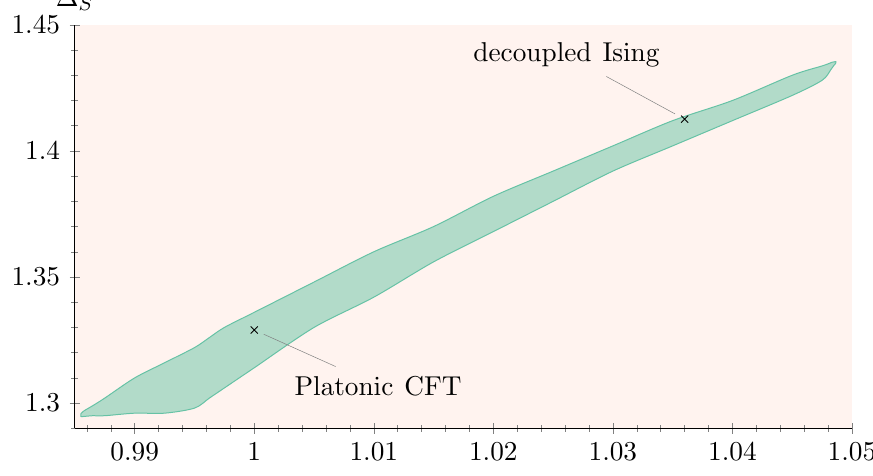
Figure 5: Plot of the projection of the three-dimensional allowed region in ( ∆ φ , ∆ , ∆ ) onto the ∆ - ∆ plane using the assumptions S Y S Y